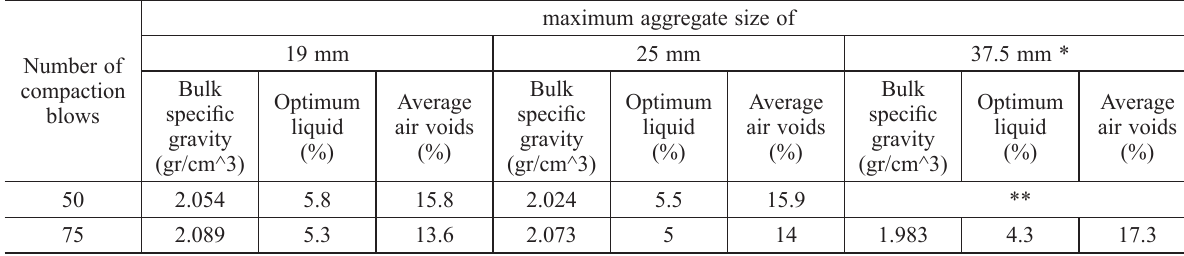
maximum aggregate size